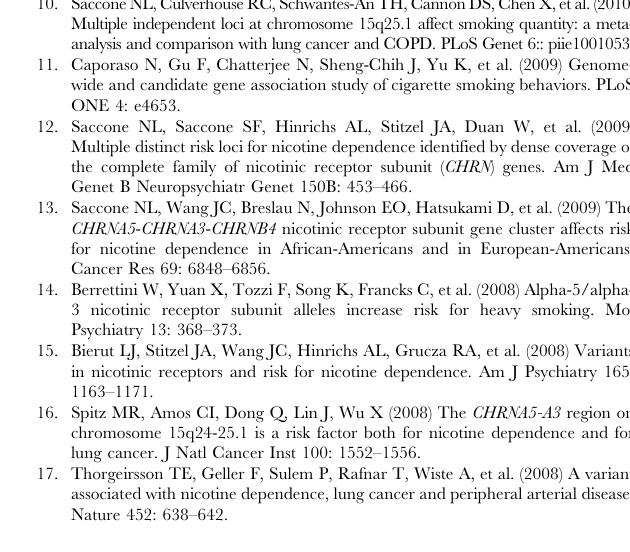
circle or open circle, respectively). (B) The percent rs16969968-[G] (%G) allelic expression from CHRNA5 is shown for all heterozy- gous individuals tested in the PFC (black symbols; individuals 1 through 6 are represented as a closed square, open square, closed triangle, open triangle, closed circle or open circle, respectively), the Amyg (blue symbols; individuals 7, 8, and 10 through 12 are represented as a closed square, open square, and open triangle, closed circle or open circle, respectively) or the Nacc (red symbols; individuals 7 through 12 are represented as a closed square, open square, closed triangle, open triangle, closed circle or open circle, respectively). Note that individual ‘‘7’’ (closed square) remains AEI-positive with strong rs16966968-[G] expression (70–75%) in both the Amyg (blue square) and Nacc (red square). (TIF) Figure S3 Concordance between CHRNA5 AEI (80:20 %G:%A) and heterozygosity at SNPs rs880395 and rs7164030. An 852 bp region of the CHRNA5 distal promoter region ( , 13.5 kb upstream of the t.s.s.) containing distal promoter SNPs rs880395and rs7164030 was amplified by PCR and amplicons digested with either Alu I (cuts the minor allele at rs880395) or Dde I (cuts the minor allele at rs7164030). The Alu I and Dde I digests are shown. Asterisks (*) indicate the presence of the minor allele product in both digests. Only individual ‘‘7’’ (with arrow) showed the presence of the minor alleles at both of these distal promoter SNPs and also showed CHRNA5 allelic expression imbalance (see Figure 5B). (TIF) Table S1 PCR and QuikChange H Primers and Param- eters. (XLS) Table S2 Lack of correlation between CHRNA3 pro- moter haplotypes and